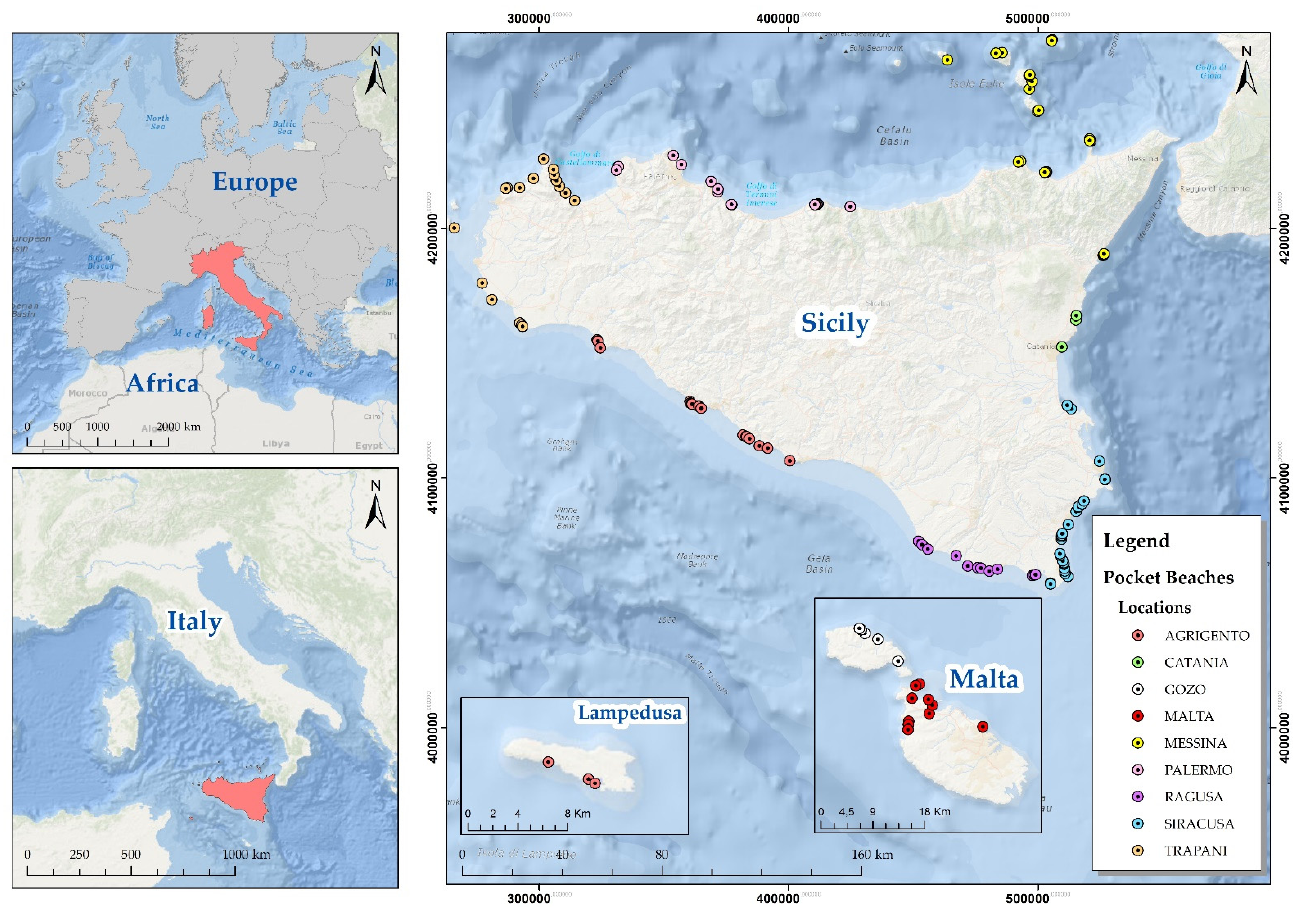
Figure 1. Geographical framework of the study area (map adapted from ESRI, GEBCO, NOAA, National Geographic, Garmin, HERE, Geonames.org, and other contributors).